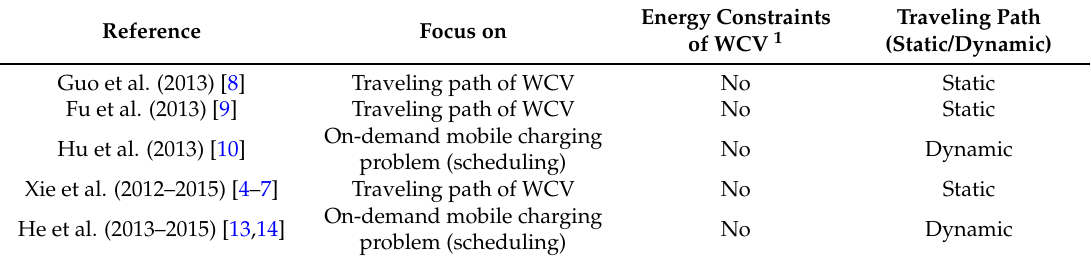
Table 1. Comparison of the recent developments in wireless rechargeable sensor network (WRSN).